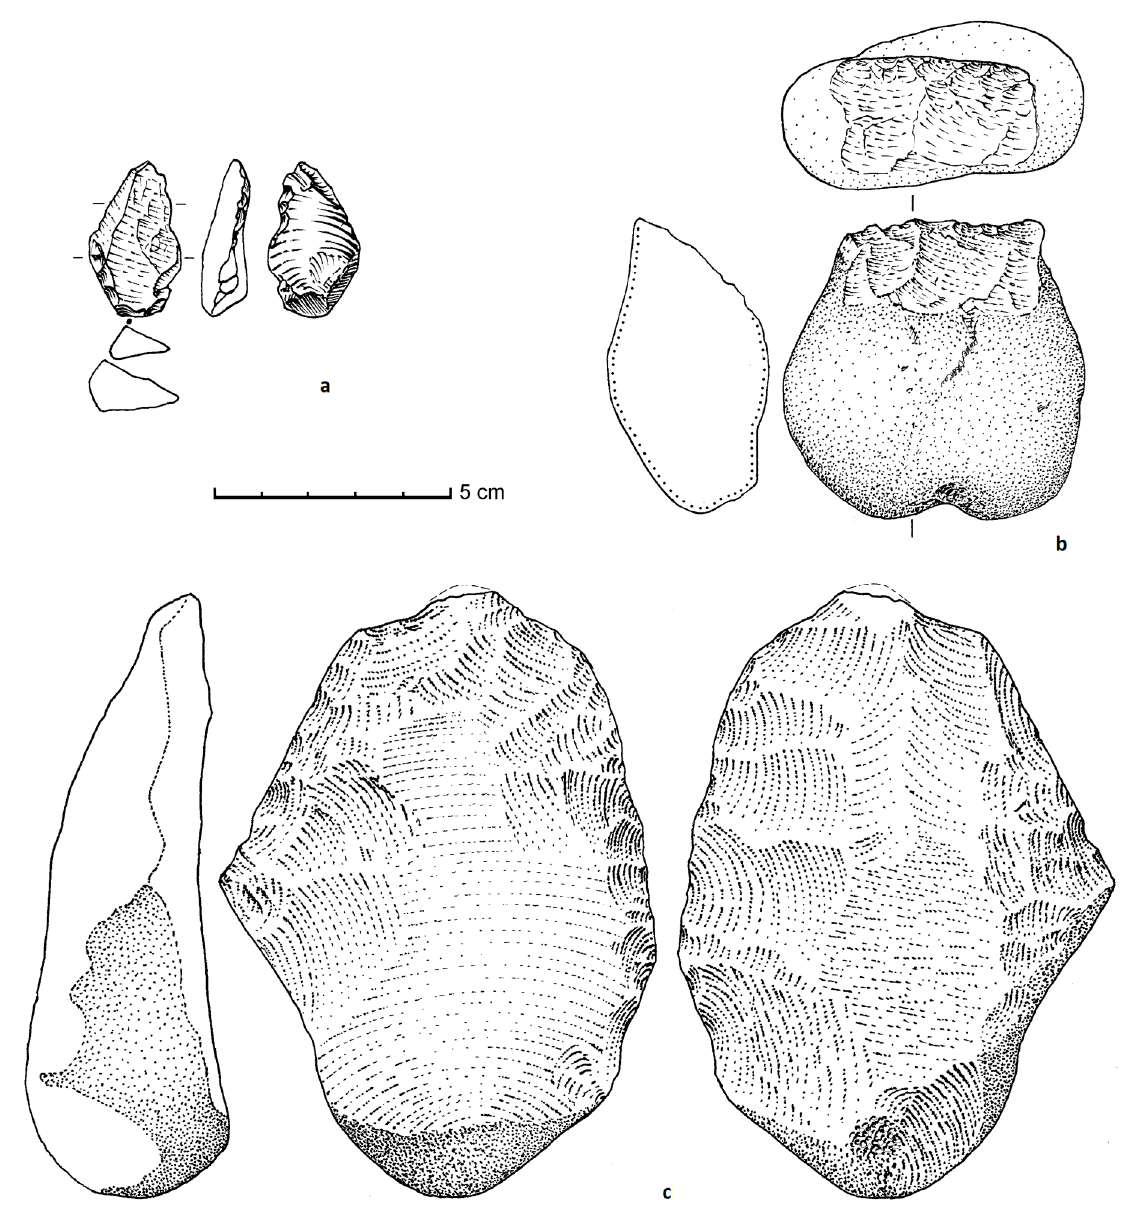
Figure 10. Münster-Sarmsheim. Some of the artefacts originating out of the terrace gravel at the Kesslers-Berg quarry. ( a ) agate flake; ( b ) chopper (vein quartz); ( c ) ovate bifacially worked large cutting Kesslers-Berg quarry. ( a ) agate flake, ( b ) chopper (vein quartz), ( c ) ovate bifacially worked large tool on a quartzite flake. (Drawings: L. cutting tool on a quartzite flake. (Drawings: L. Fiedler.).